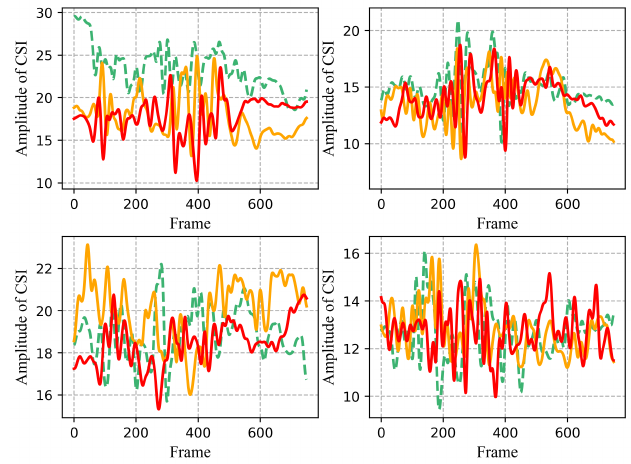
Figure 3. CSI amplitude of four distinct human activities at the identical position. The three curves in each subgraph represent three samples for the same action. The horizontal axis denotes the frame; the ordinate indicates amplitude of CSI.